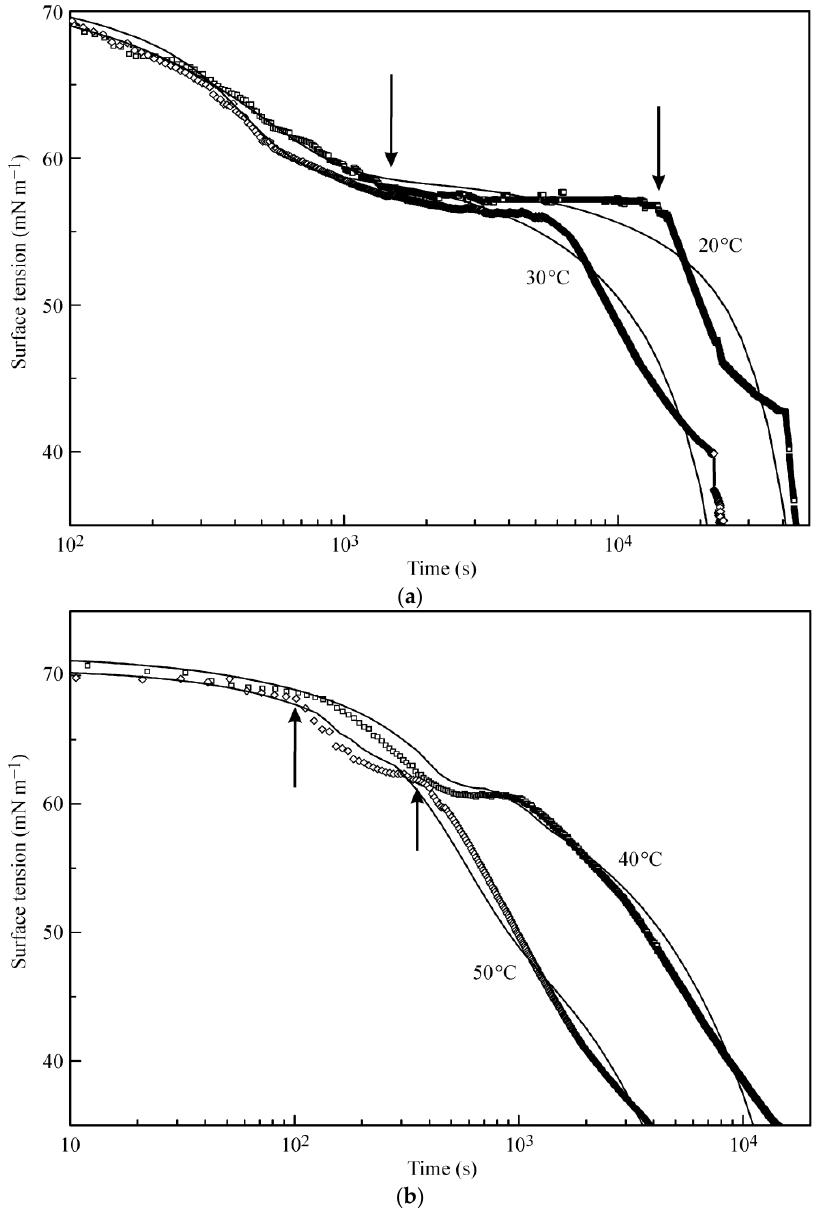
Figure 2. Dynamic surface tension at water drops in air saturated by heptane vapor at different temperatures: 20 and 30 °C ( a ); and 40 and 50 °C ( b ). Points, experimental data; curves, theoretical calculations assuming five layers, and values of parameters listed in Table 1. Arrows indicate the positions of characteristic points. For detailed explanation, see text.